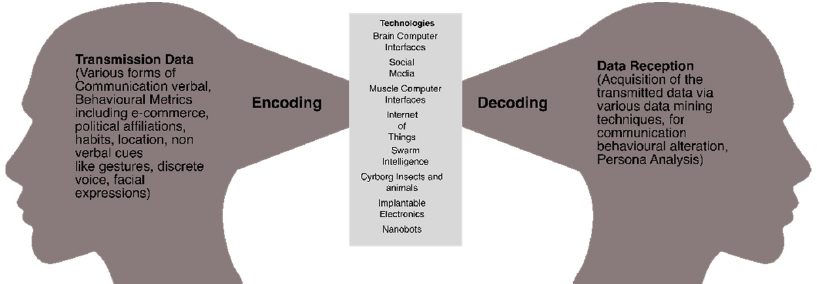
Figure 1. Information and technologies leading to the human-machine hive mind in the fu- ture. Figure 2. The various data gathered via various hive-mind technologies and how they could be misused.